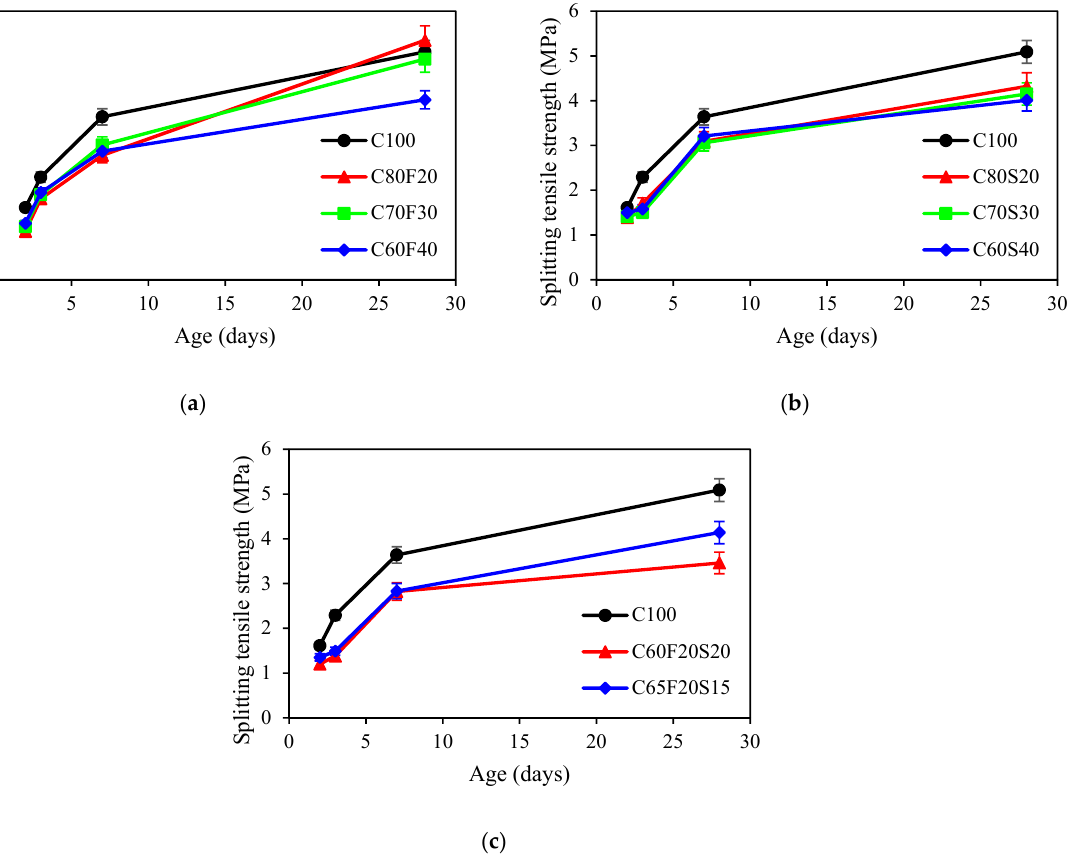
Figure 5. Splitting tensile strength of concrete: ( a ) fly ash group; ( b ) GGBFS group; ( c ) ternary binder group.